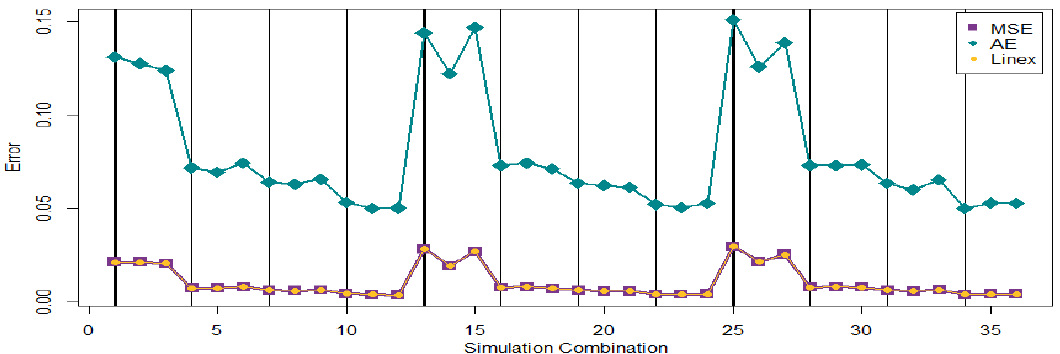
Figure 11. Overall error under β 1 = β 2